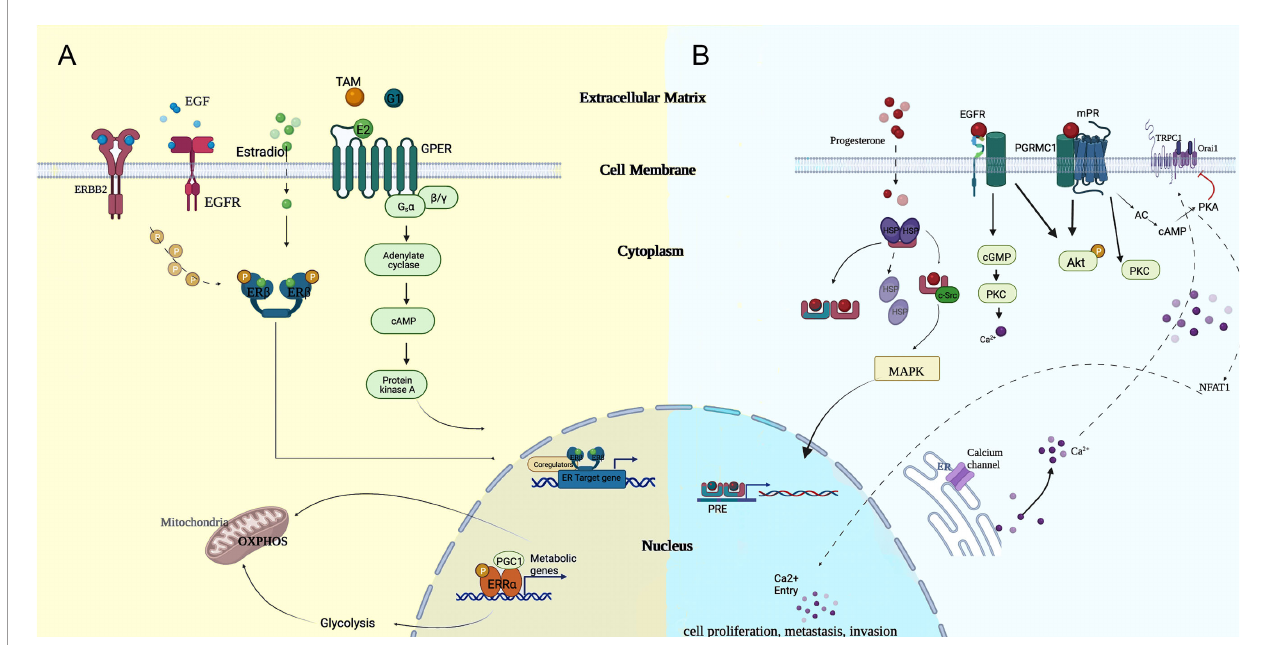
FIGURE 1 | Potential modes of genomic and non-genomic approaches of (A) estradiol and (B) progesterone, which cooperated in regulating the carcinogenesis process. cGMP, cyclic guanosine monophosphate; EGF, epidermal growth factor; ER, endoplasmic reticulum; MAPK, mitogen-activated protein kinase; NFAT1, nuclear factor of activated T cell; OXPHOS, oxidative phosphorylation; PGC1, proliferator activated receptor-gamma co-activator 1; PKC, protein kinase C; PRE, progesterone reactive element; TAM,